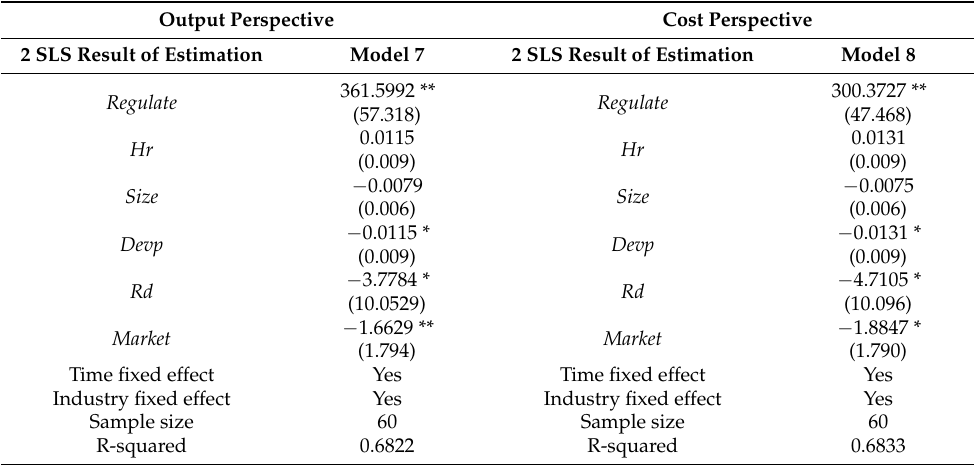
Table 4. Estimation results of 2 SLS